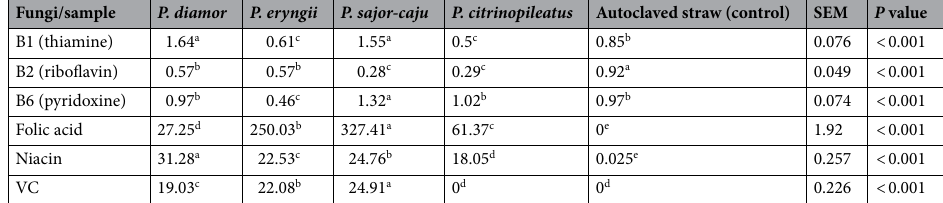
Table 4. Vitamin composition (mg/kg) of corn stover after 21 days of incubation with various white rot fungi ( Pleurotus sp.) or control. SEM: standard error of mean. a–d Within a row, means without a common superscript differed ( P <